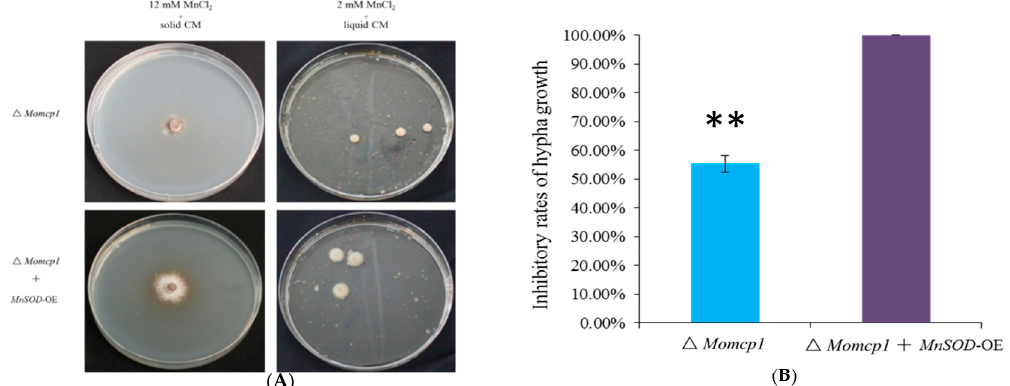
Figure 8. Overexpression of MnSOD restored the Mn 2+ tolerance in ∆ Momcp1 mutant. ( A ) The hypha growth of ∆ Momcp1 and ∆ Momcp1 with the overexpression of MnSOD under excessive Mn 2+ (Left panel, 12 mM Mn 2+ in solid CM. Right panel, 2 mM Mn 2+ in liquid CM). ( B ) The inhibitory rates of the hypha growth in solid CM with excessive MnCl 2 . The significant difference was determined by a t -test; **, p < 0.01.